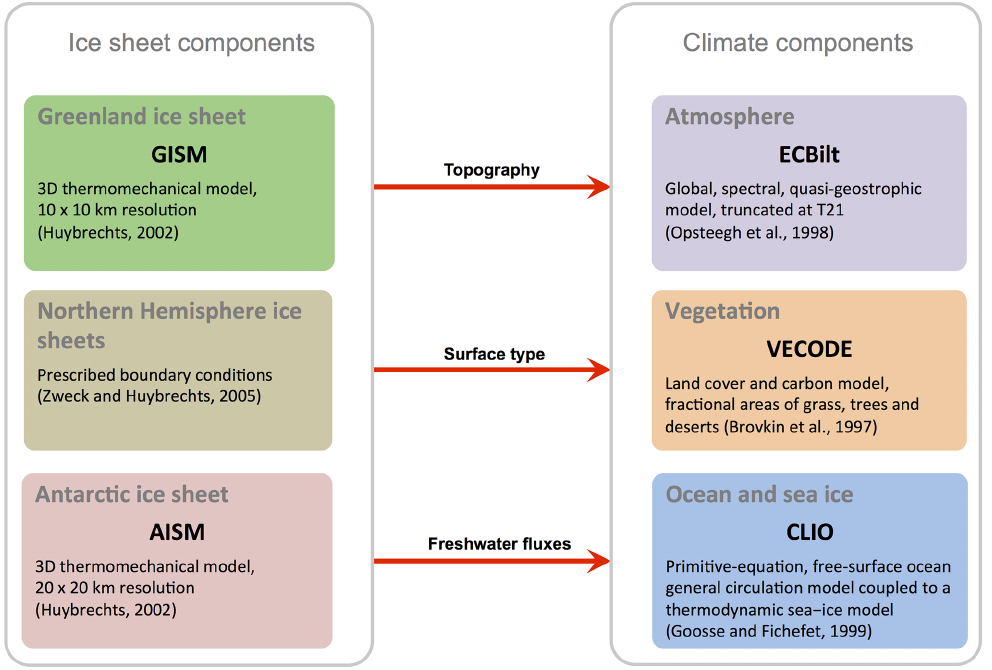
Figure 1. LOVECLIM model setup for the present study including prescribed ice sheet boundary conditions from the Northern Hemisphere, Greenland, and Antarctic ice